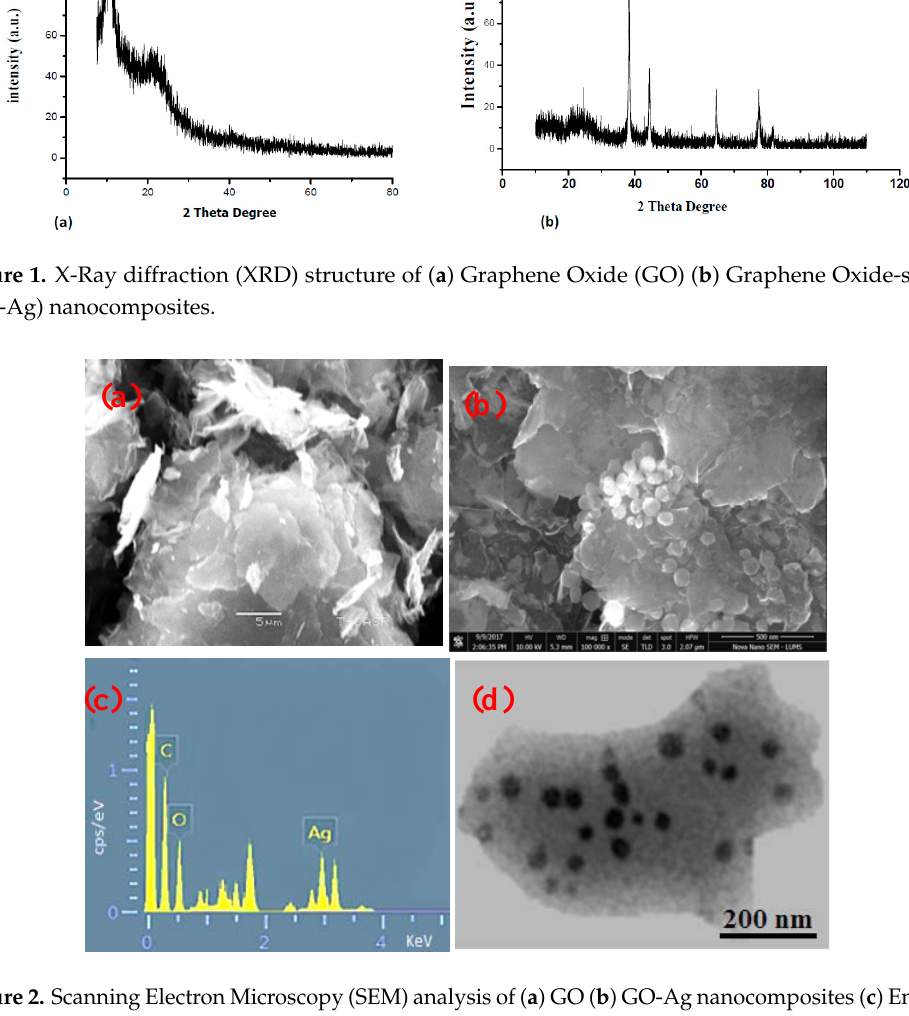
Figure 2. Scanning Electron Microscopy (SEM) analysis of ( a ) GO ( b ) GO-Ag nanocomposites ( c ) Energy Dispersive X-rays (EDAX) analysis of GO-Ag nanocomposites ( d ) Transmission electron microscopy (TEM) of GO-Ag.